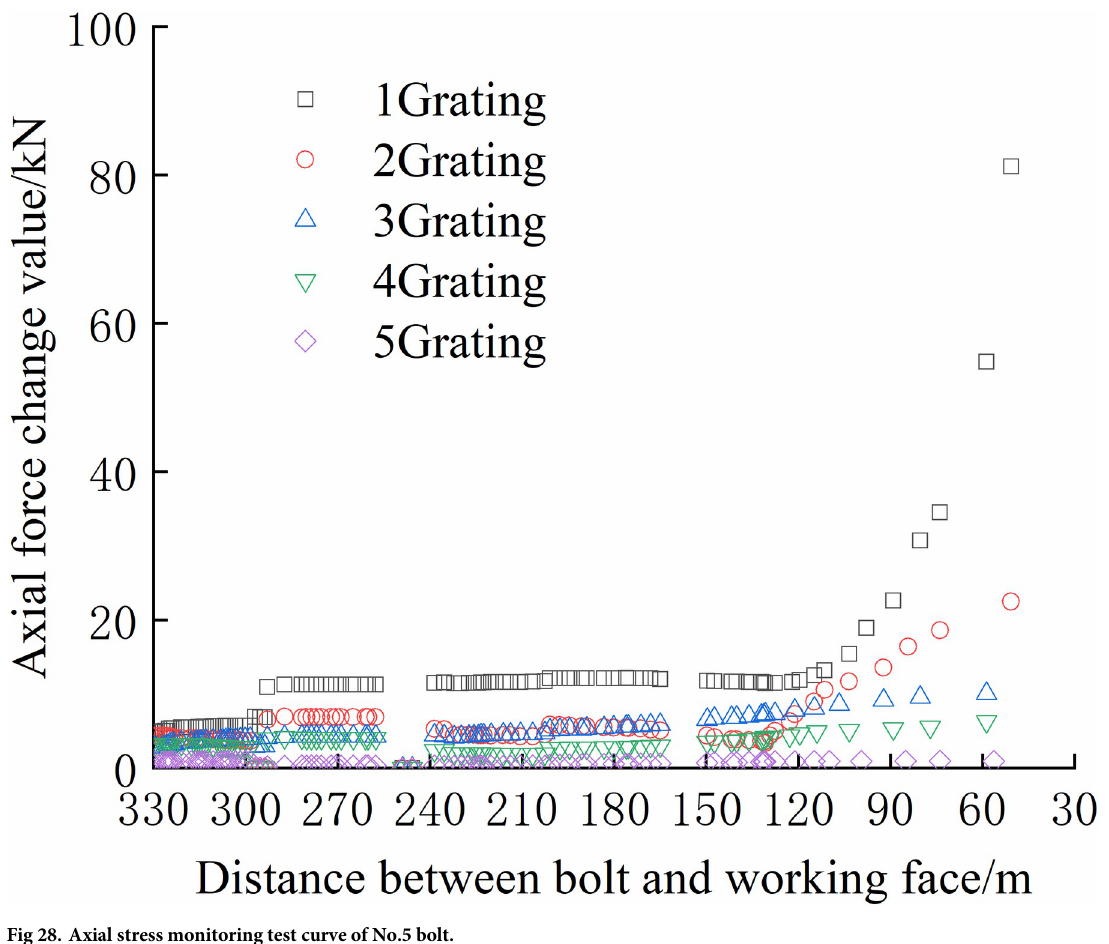
Fig 28. Axial stress monitoring test curve of No.5 bolt.